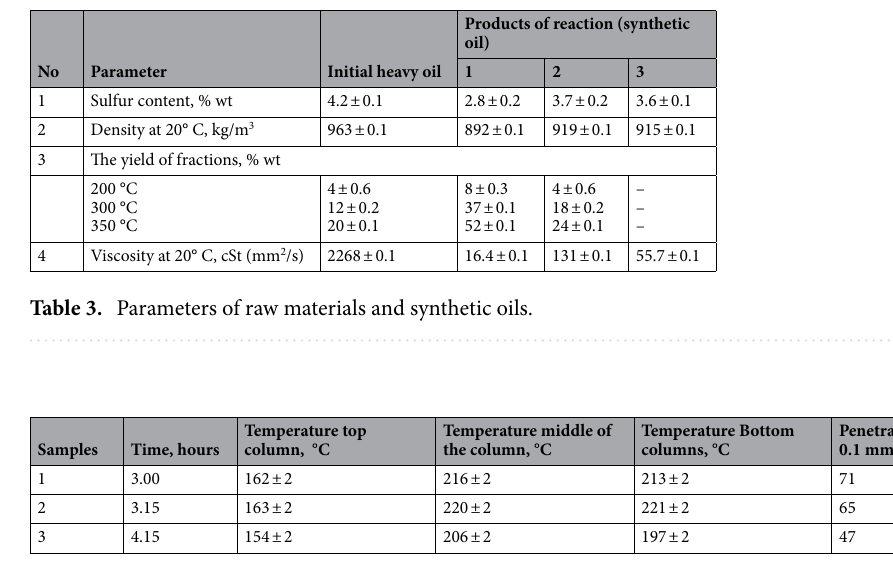
Table 4. Results of the oxidized bitumen after oxidation process.